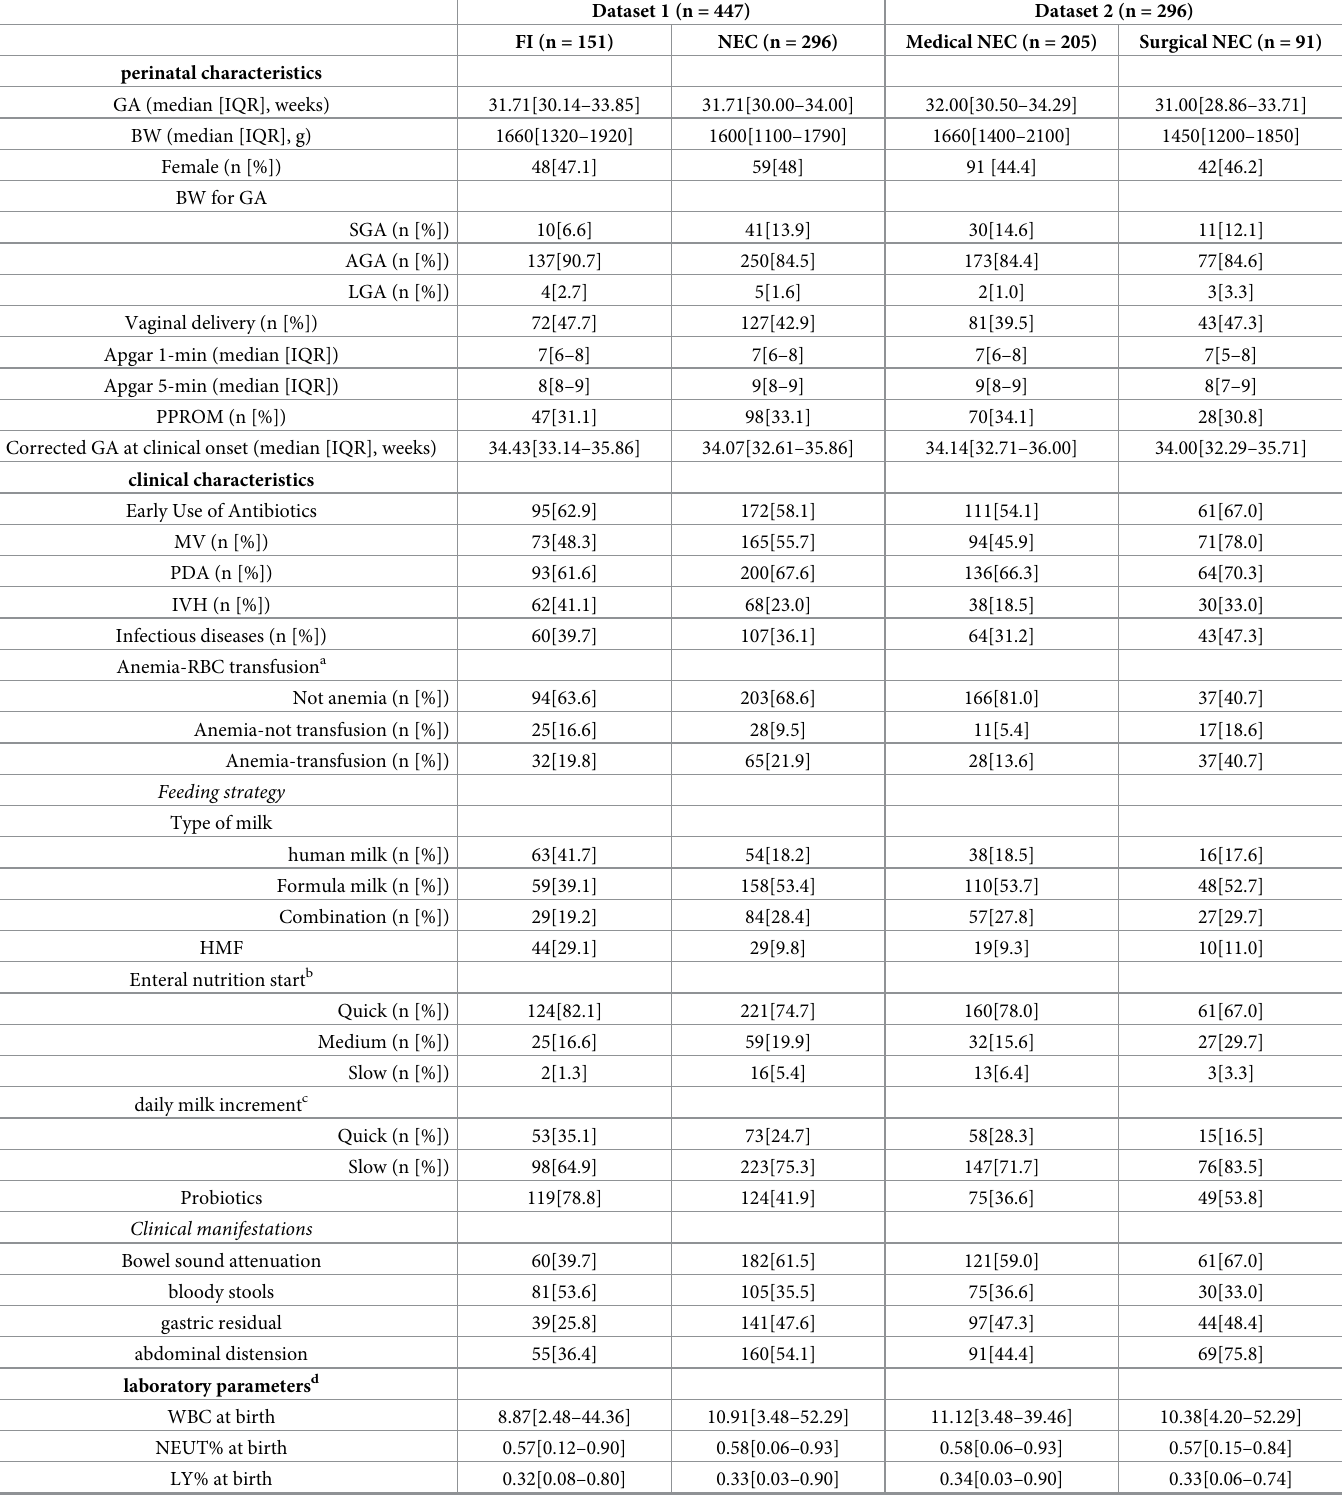
Table 2. Main perinatal and clinical characteristics of two